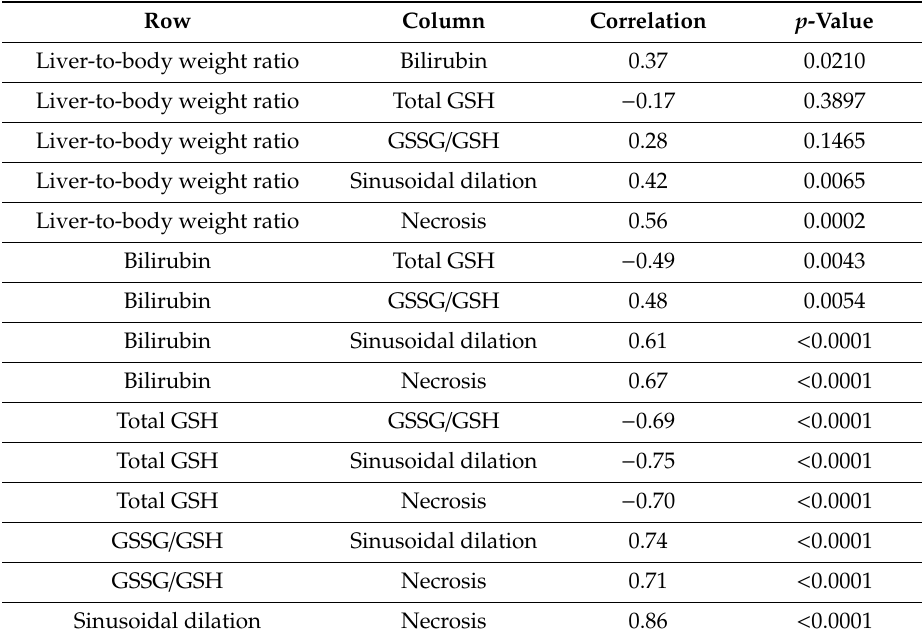
Table 2. List-wise format of each of the 15 unique correlations in the correlation matrix. Row Column Correlation p -Value Liver-to-body weight ratio Bilirubin Liver-to-body weight